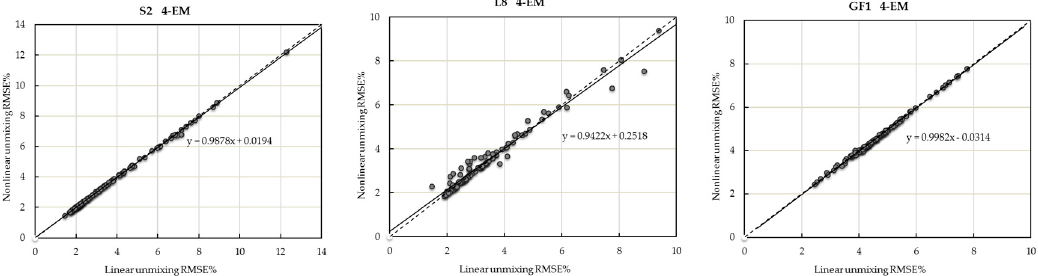
Figure8. UnmixingrelativeRMSErelationshipbetweenNSMMandLSMM.N = Figure 8. Unmixing relative RMSE relationship between NSMM and LSMM. N = 111 in all circumstances.